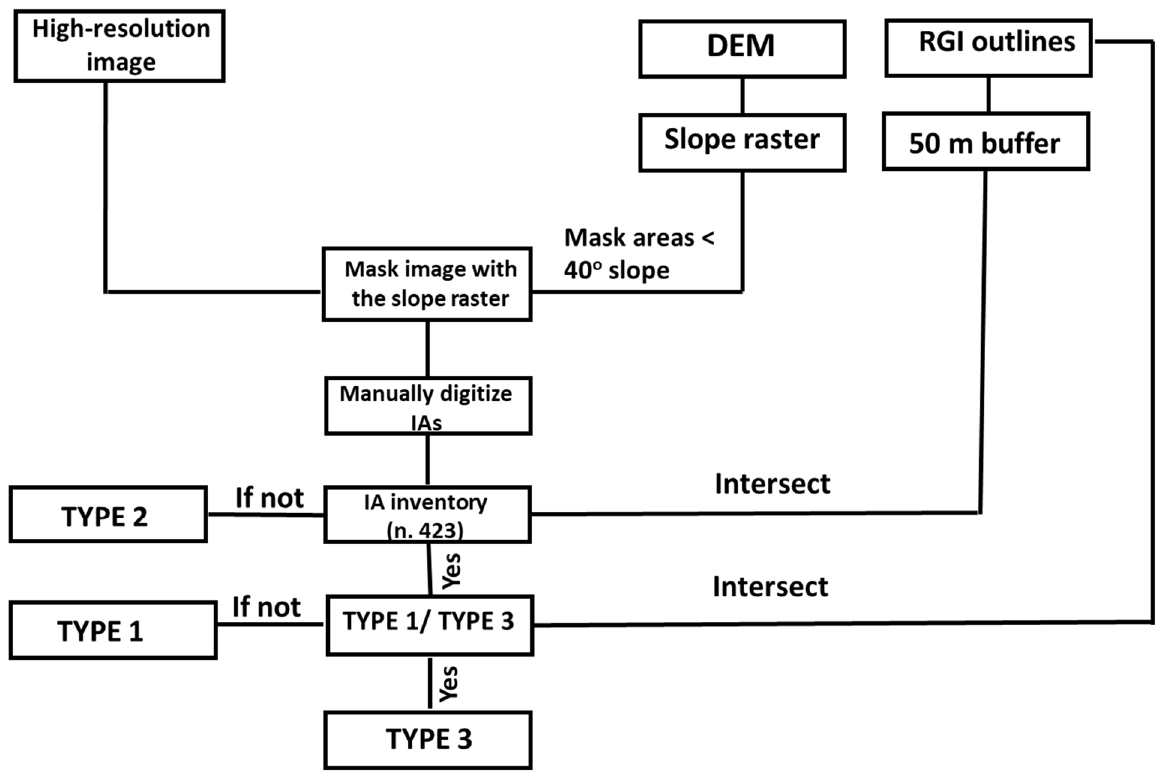
Figure 6. Methodology flowchart for differentiating ice aprons into different